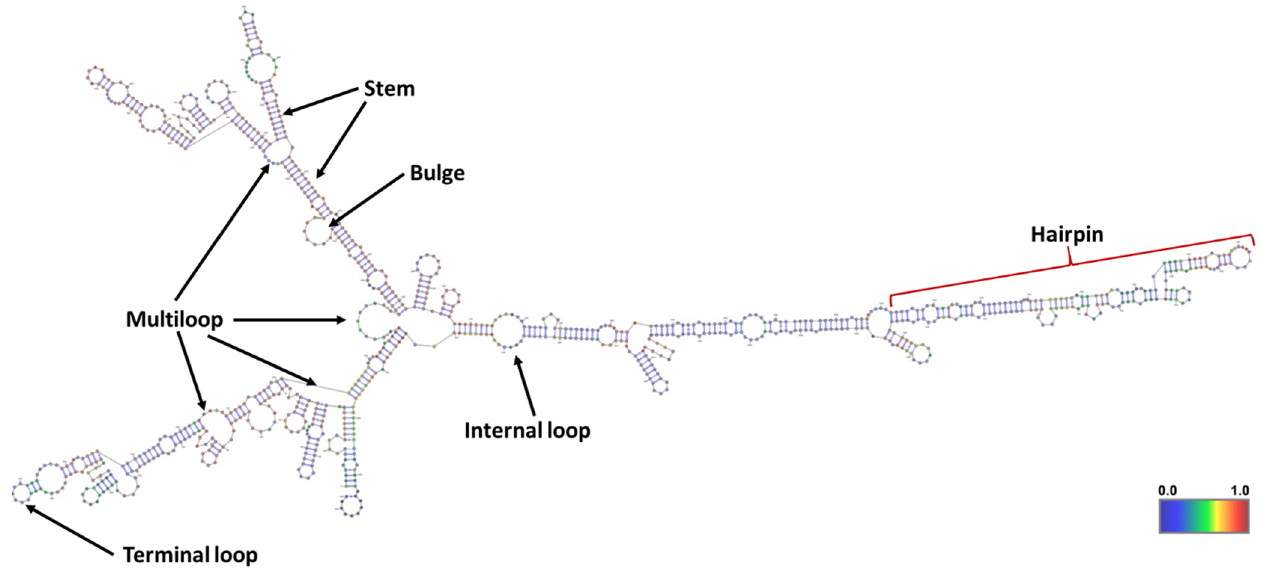
Figure 3. The minimum free energy (MFE) secondary structure of ABHD11-AS1 lncRNA predicted using RNAfold web server. Different components in the secondary structure of lncRNA corresponding to the topology (or shape) of base pairings were defined.